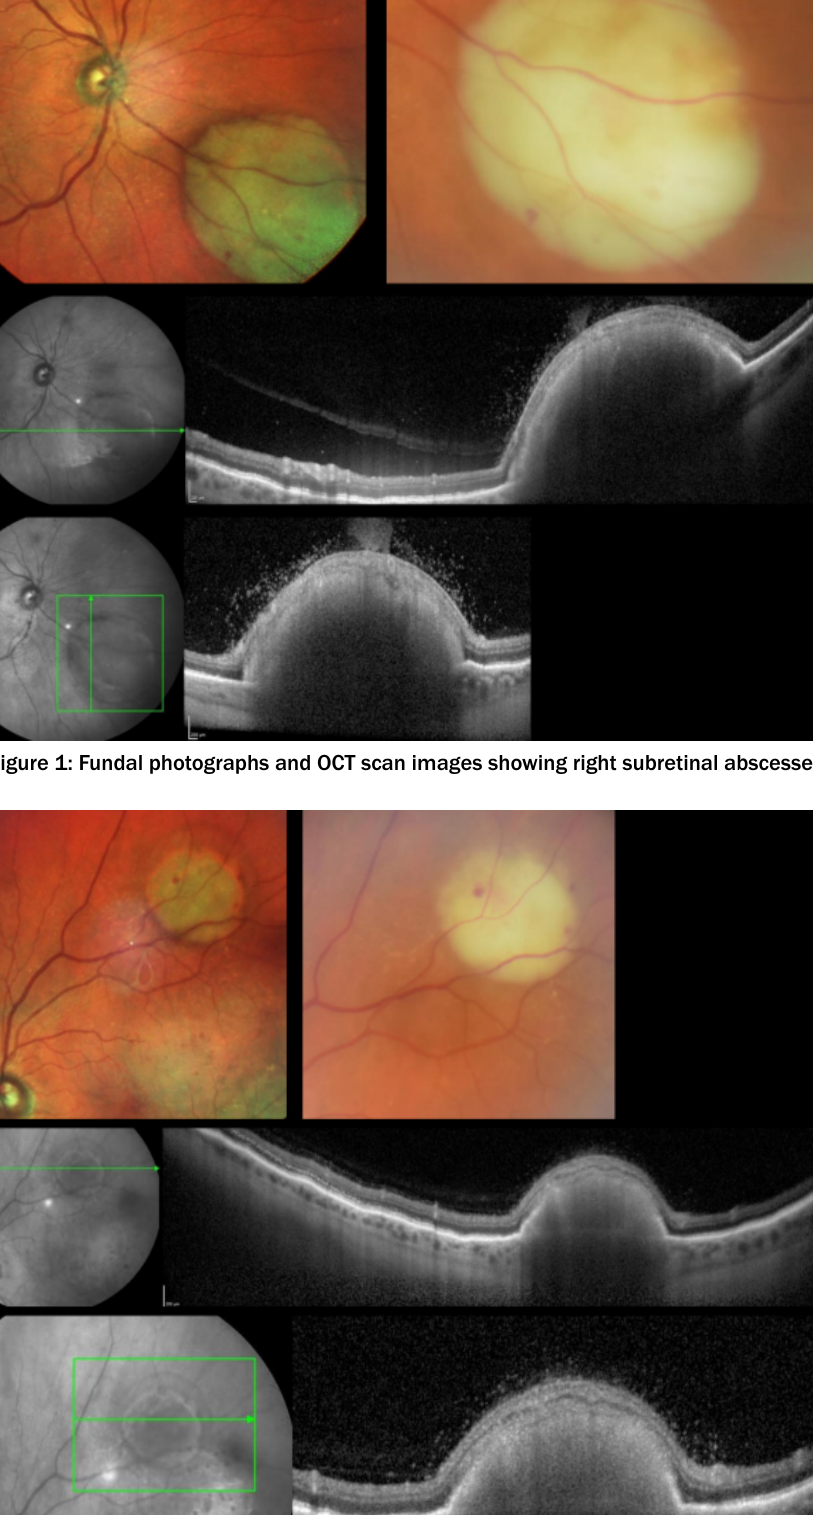
2/4GMS Ophthalmology Cases 2021, Vol. 11,